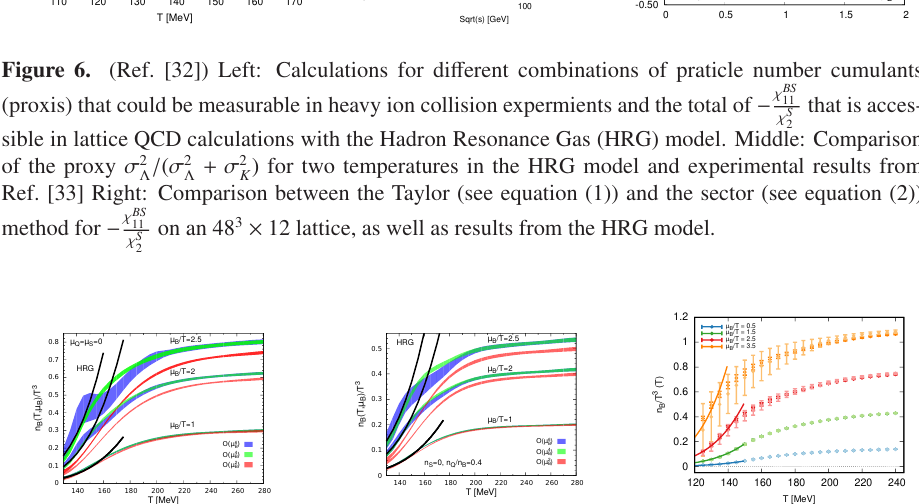
Figure 7. (Ref. [25]) The extrapolation to finite baryon number n B done by the Taylor method (see equation (1)): Left: µ Q = µ S = 0, Middle: n S = 0 and n Q / n B = 0 . 4, Right: (Ref. [34]) The pressure and the baryon number from the resummed extrapolation. The lighter bars show the increased error by the inclusion of a higher order